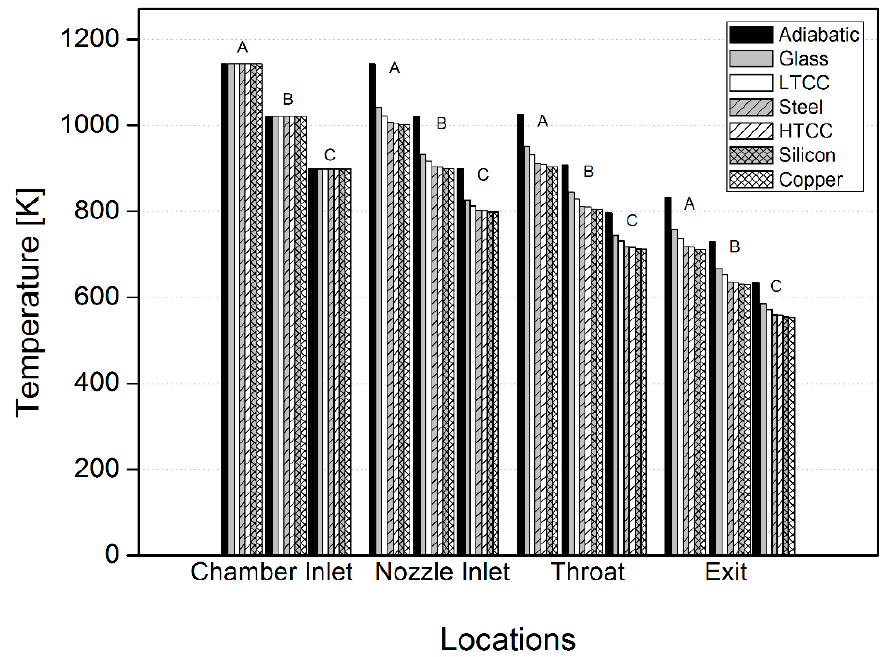
Figure 5. Temperature at four different locations of the microthruster affected by variation in heat loss, depending on structural materials and propellant weight percentages (A: 95%, B: 90%, C: 85% H 2 O 2 ).